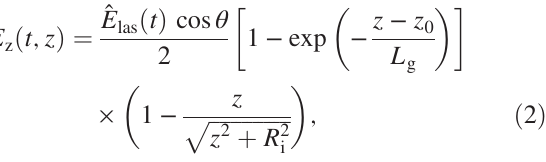
FIG. 2. TPS proton spectra in arbitrary units and logarithmic scale, for τ prepulse delay and varying pulse duration (b). Angular-spectral proton number distributions measured with the calibrated TOF detector for 4 fs (c), 27 fs (d), and 200 fs